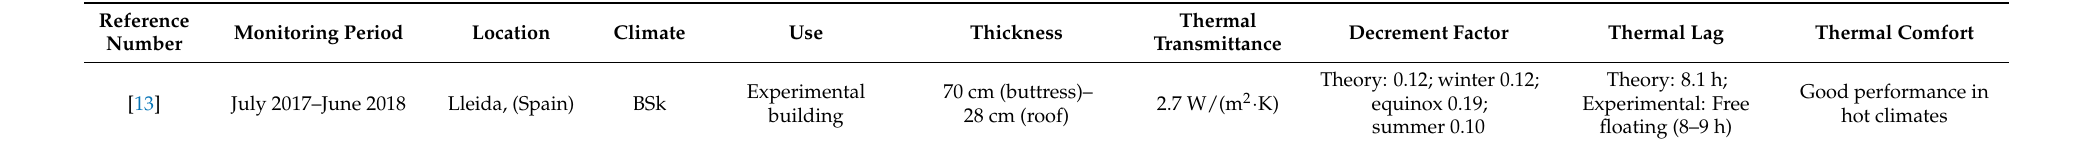
Table 4. Building characteristics and thermal performance of the earthbag monitored